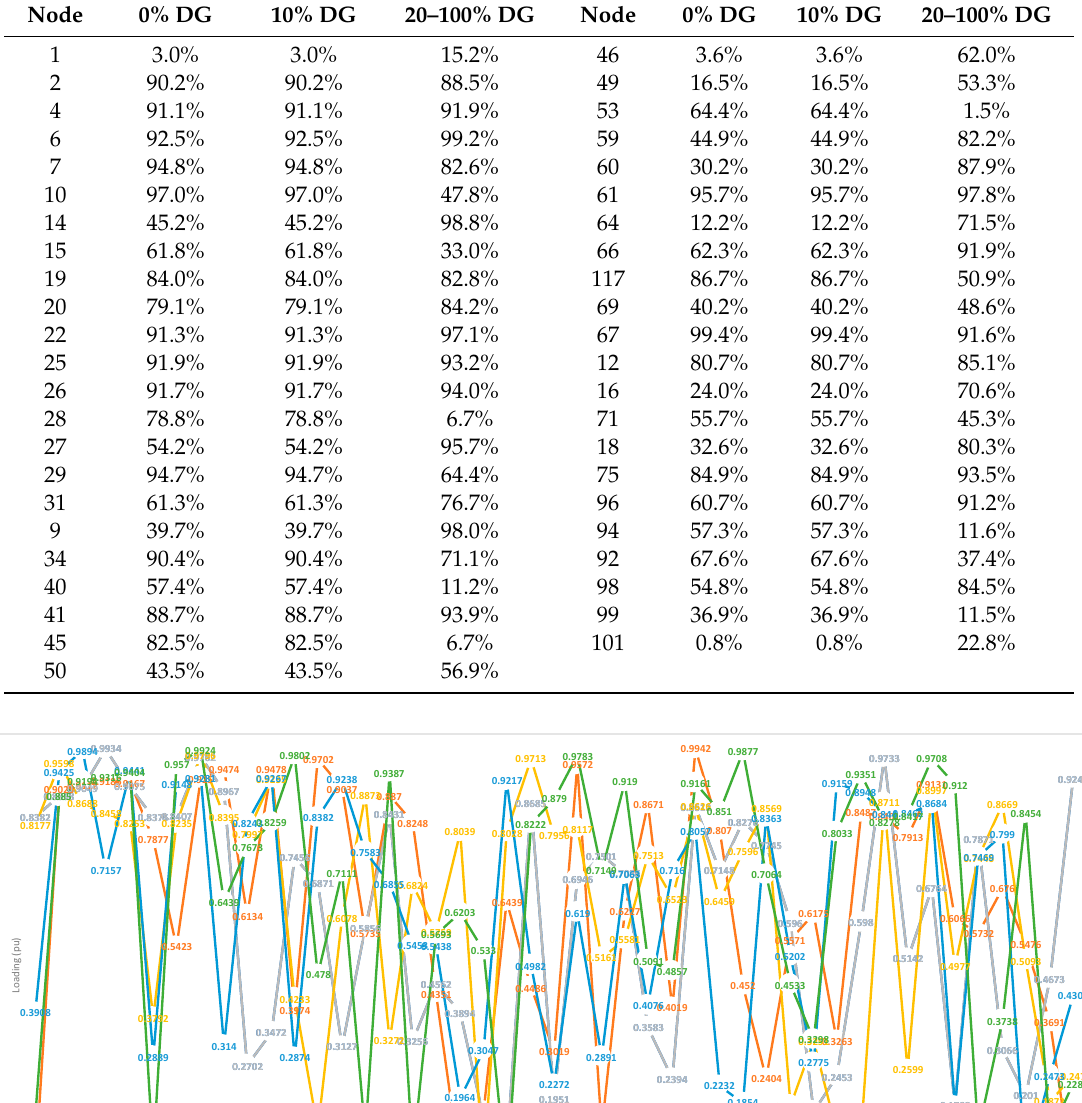
Table 7. Loading per node for case 2.